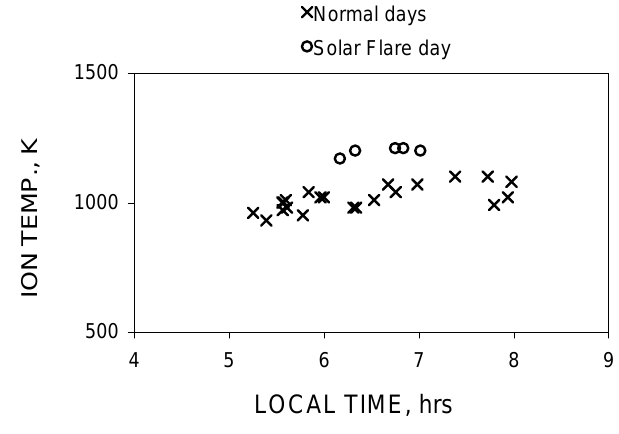
Fig. 2. Variation of ion temperature recorded by the SROSS-C2 satellite during solar flares and normal days at